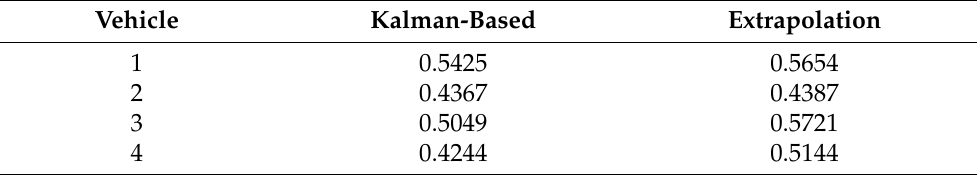
Table 1. Comparison of the ISE index for the tracking error for both strategies.